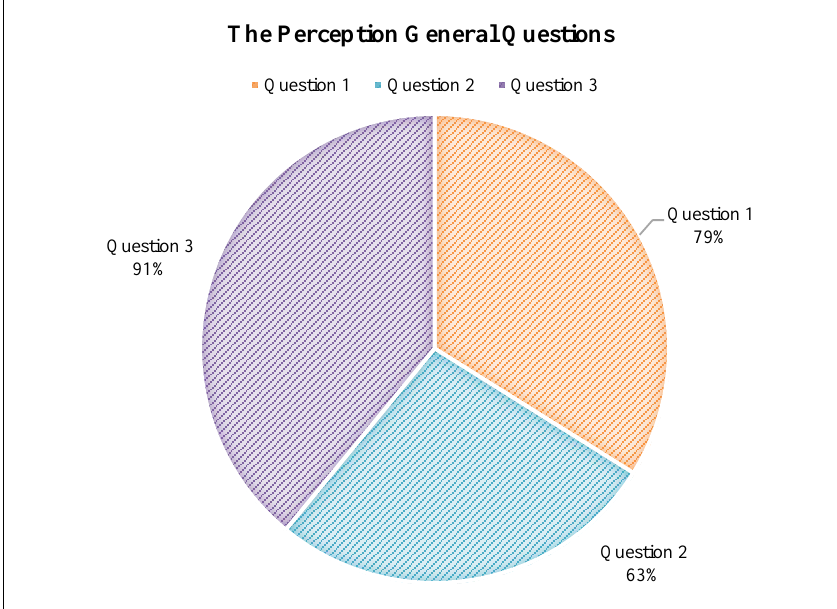
Figure 3. Thailand should ratify and comply with the Convention, ratification of the Convention will reduce on enforced disappearance, and Thailand has customary obligation to comply with the